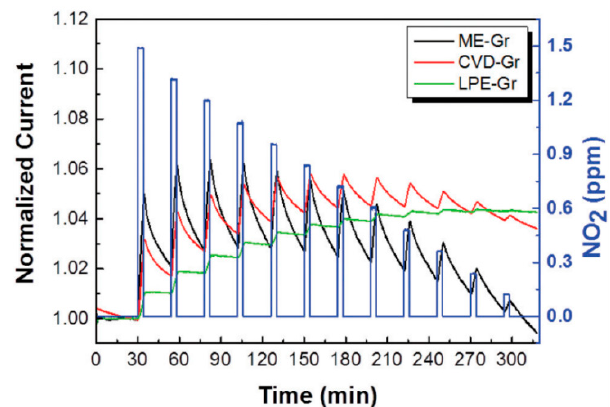
Figure 11. Real-time current behavior of ME-Gr (black line), CVD-Gr (red line) and LPE-Gr (green line) based chemi-resistors upon exposure to sequential NO 2 pulses (blue rectangles) at decreasing concentrations from 1.5 down to 0.12 ppm. Each exposure step lasts 4 min, preceded and followed by 20 min long baseline and recovery phases, respectively, in N 2 atmosphere. The baseline preceding the first pulse lasts 30 min in order to allow the device to better stabilize in the test chamber. The current is normalized at the value I 0 during the gas inlet of the first pulse exposure [74].